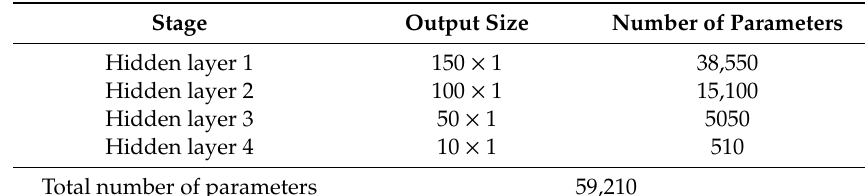
Table 5. Details of structure and parameters of sDSAE&KNN.